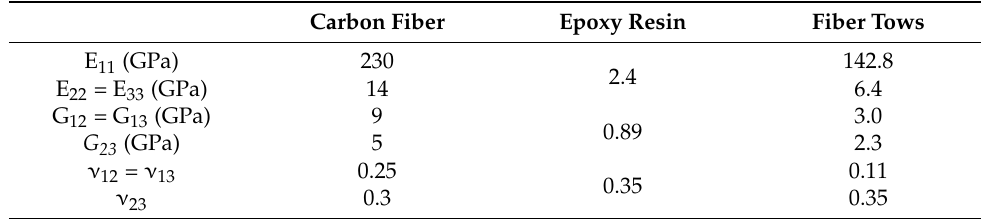
Table 4. Basic properties of constituents and yarns.